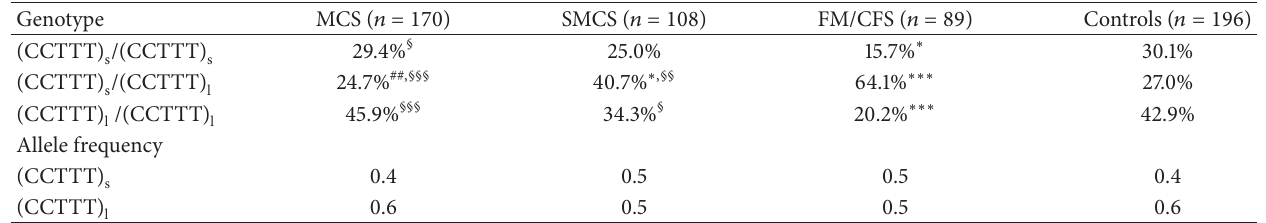
Table 3: Genotype and allele frequencies of the NOS2A promoter pentanucleotide microsatellite − 2.5 kb (CCTTT ) 𝑛 short and long repeats in IEI patients and healthy